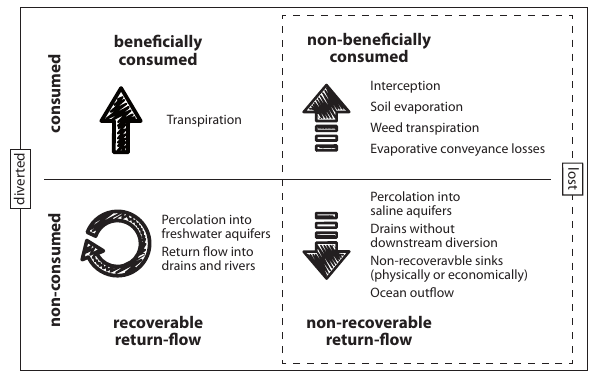
Figure 1. Pathways of irrigation water fluxes. All diverted water is either consumed (non-)beneficially, or re-enters rivers, reservoirs and aquifers, which makes it recoverable through return flow. Non- beneficial consumption and non-recoverable return flow can be con- sidered losses (at the basin